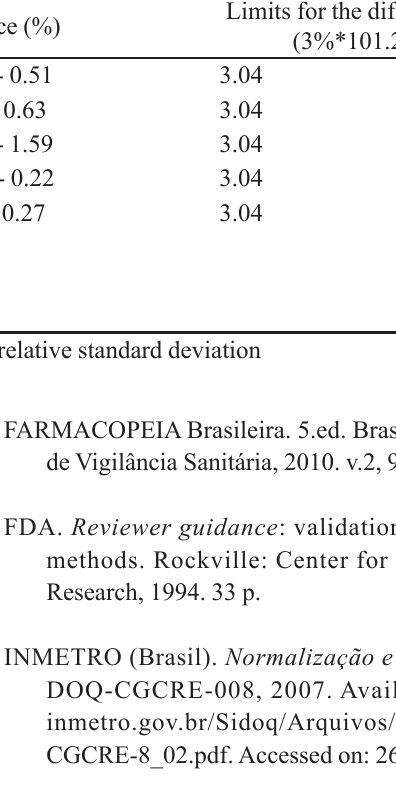
TABLE IV - Combinations tested to evaluate the robustness Content of DP